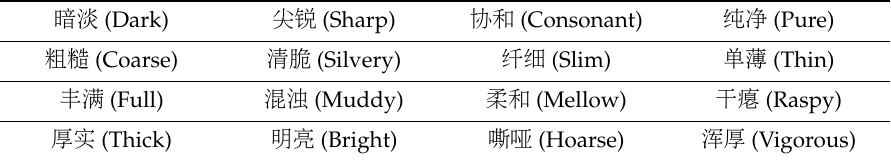
Table 3. A musical expert timbre evaluation term system, including 16 timbre evaluation terms in their original language (Chinese) and the corresponding English